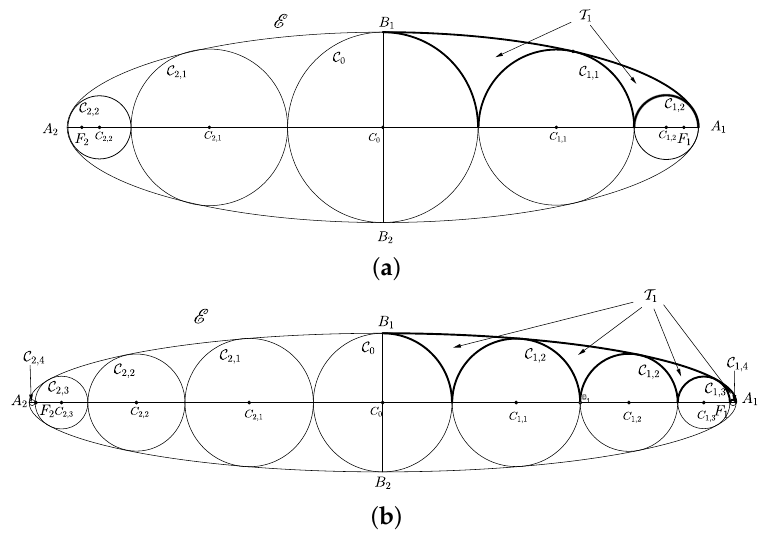
√ 11 ( a ) and a / b = 5 ( b